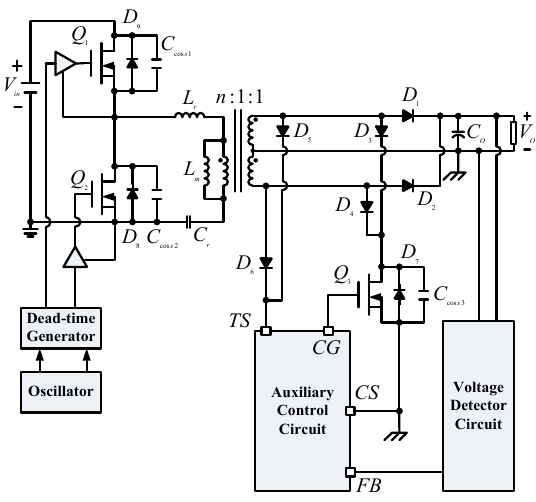
Figure 12. Structural diagram of a novel LLC control circuit.